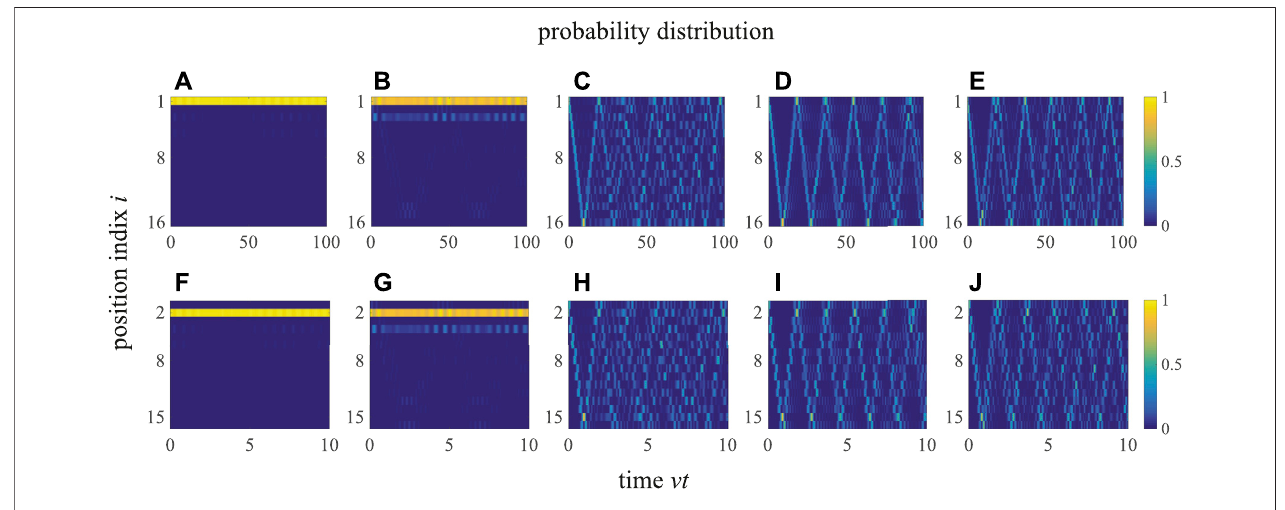
FIGURE7| (Coloronline)Timeevolutionoftheprobabilitydistributionofanopenchainfor N (cid:1) 8: (A – E) z / v (cid:1) 0.1and P 1 (0) (cid:1) 1,with (A) J / v (cid:1) 0.1, (B) J / v (cid:1) 0.3, (C) J / v (cid:1) 1.0, (D) J / v (cid:1) 1.1, (E) J / v (cid:1) 1.2; (F – J) z / v (cid:1) 10 and P 2 (0) (cid:1) 1, with (F) J / v (cid:1) 1, (G) J / v (cid:1) 3, (H) J / v (cid:1) 10, (I) J / v (cid:1) 11, (J) J / v (cid:1) 12. The phase factor is ϕ (cid:1) 0.